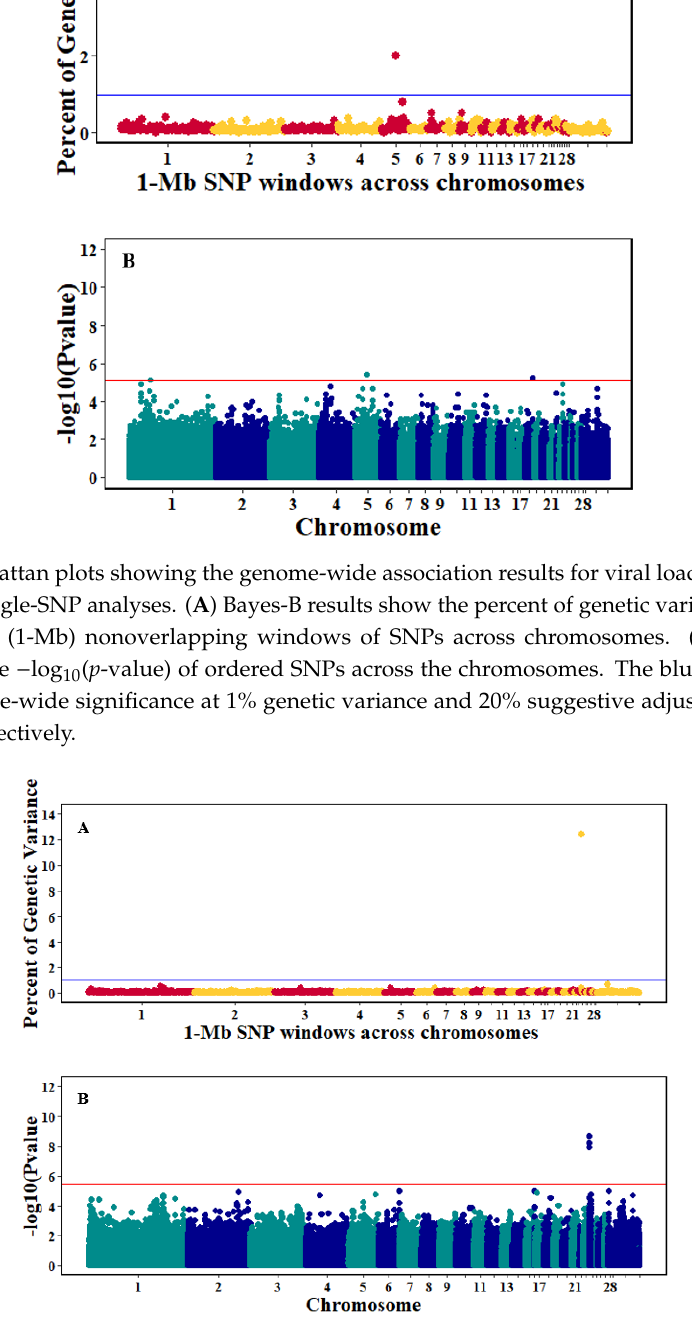
Figure 7. Manhattan plots showing the genome-wide association results for viral load at 6 dpi using Bayes-B and single-SNP analyses. ( A ) Bayes-B results show the percent of genetic variance explained by 1-Megabase (1-Mb) nonoverlapping windows of SNPs across chromosomes. ( B ) Single-SNP results show the − log 10 ( p -value) of ordered SNPs across the chromosomes. The blue and red lines indicate genome-wide significance at 1% genetic variance and 20% suggestive adjusted Bonferroni correction, respectively.